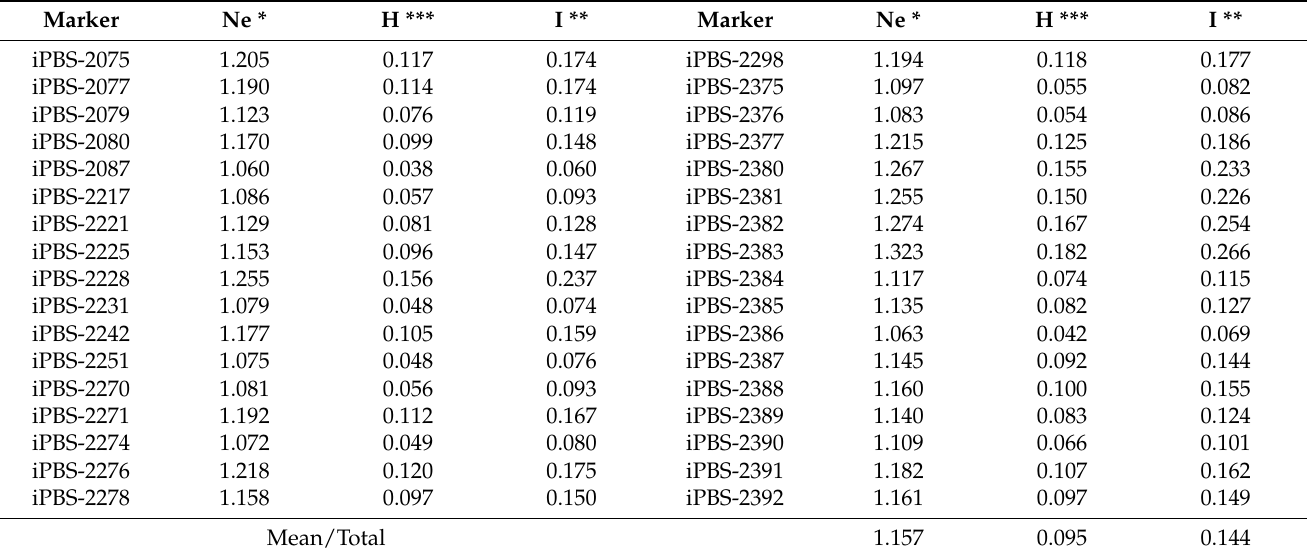
Table 4. Summary statistics for mean values for wheat varieties ( Triticum aestivum L.) assessed with iBPS